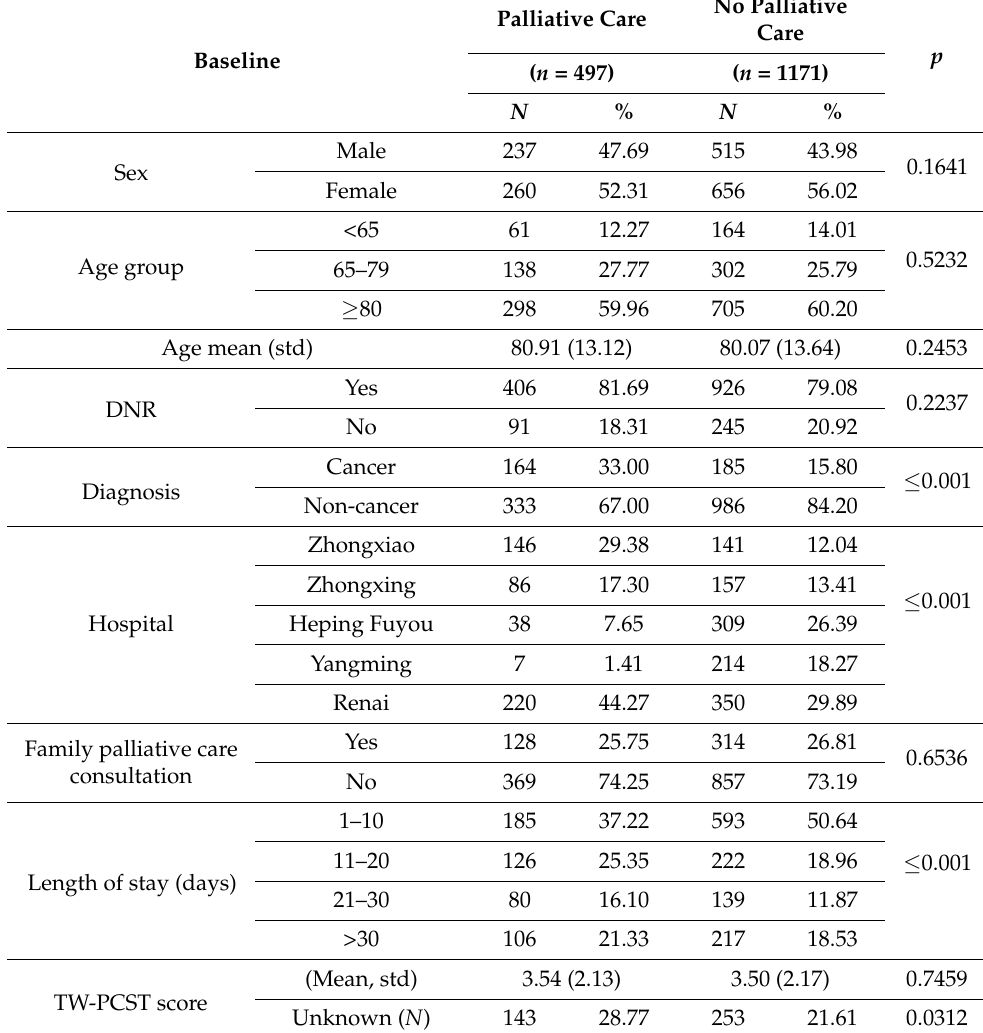
Table 2. Inpatients at end of life with and without palliative care utilization.